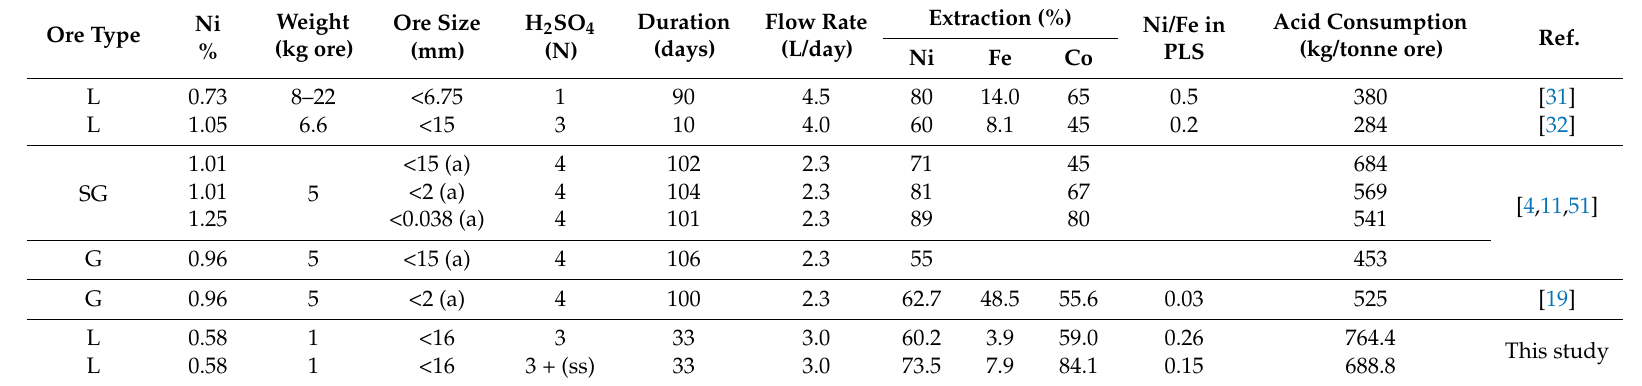
Table 4. Comparison of results of various column leaching